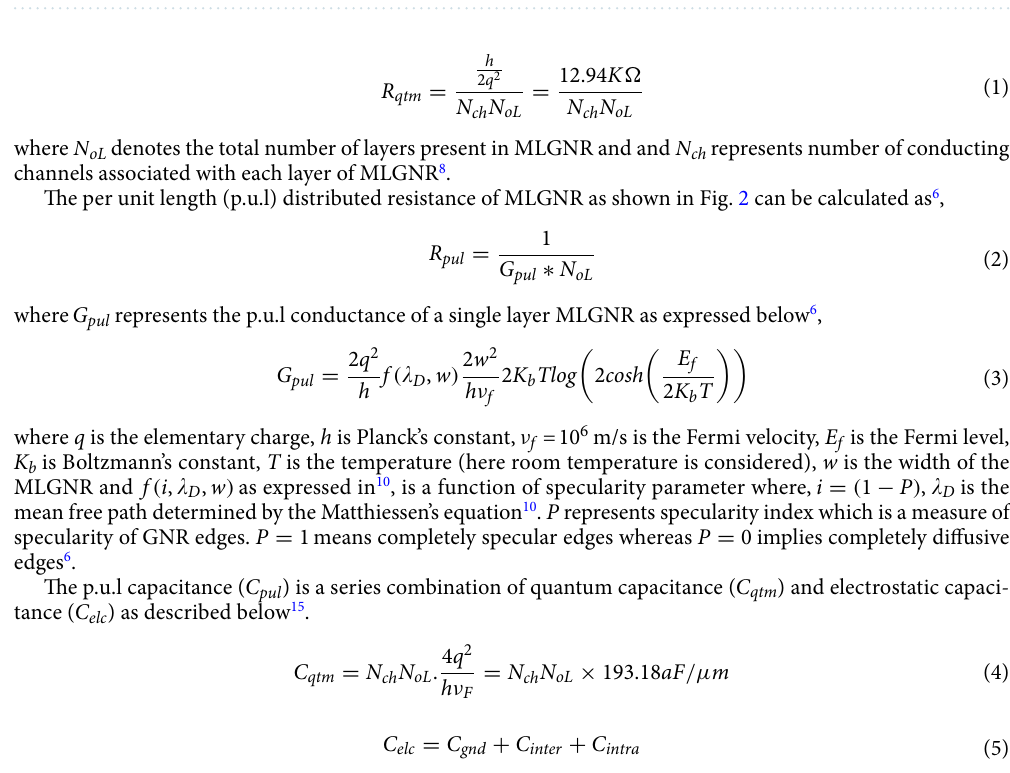
Figure 3. Electrical equivalent of three-line MLGNR interconnect